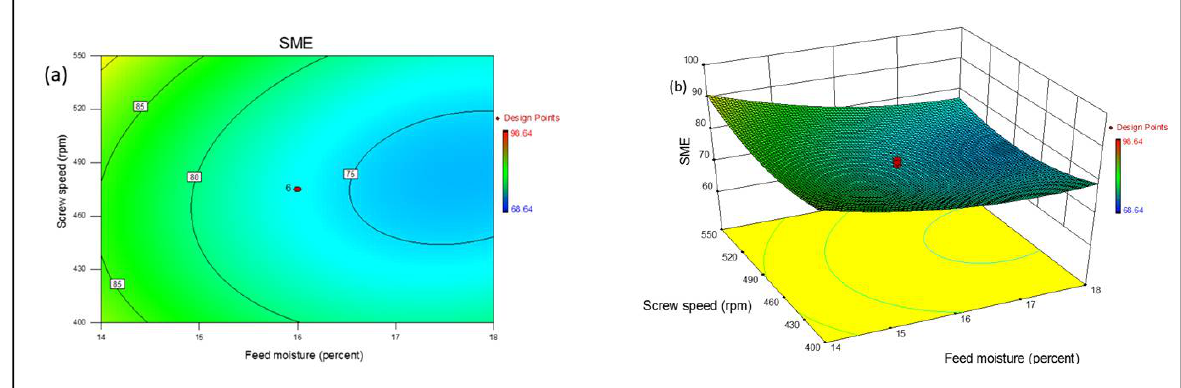
Figure 1: Contour (a) and its response surface plot depicting the behavior of expansion ratio (ER) at different screw speed and barrel temperature while the other processing variables are at center point